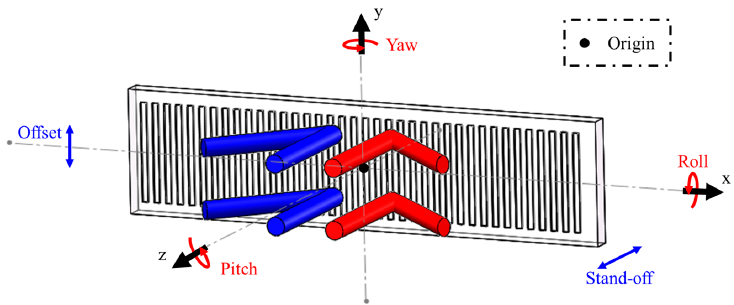
Figure 2. Distinguishing the misalignment angles (roll, yaw, and pitch), stand-off and offset.